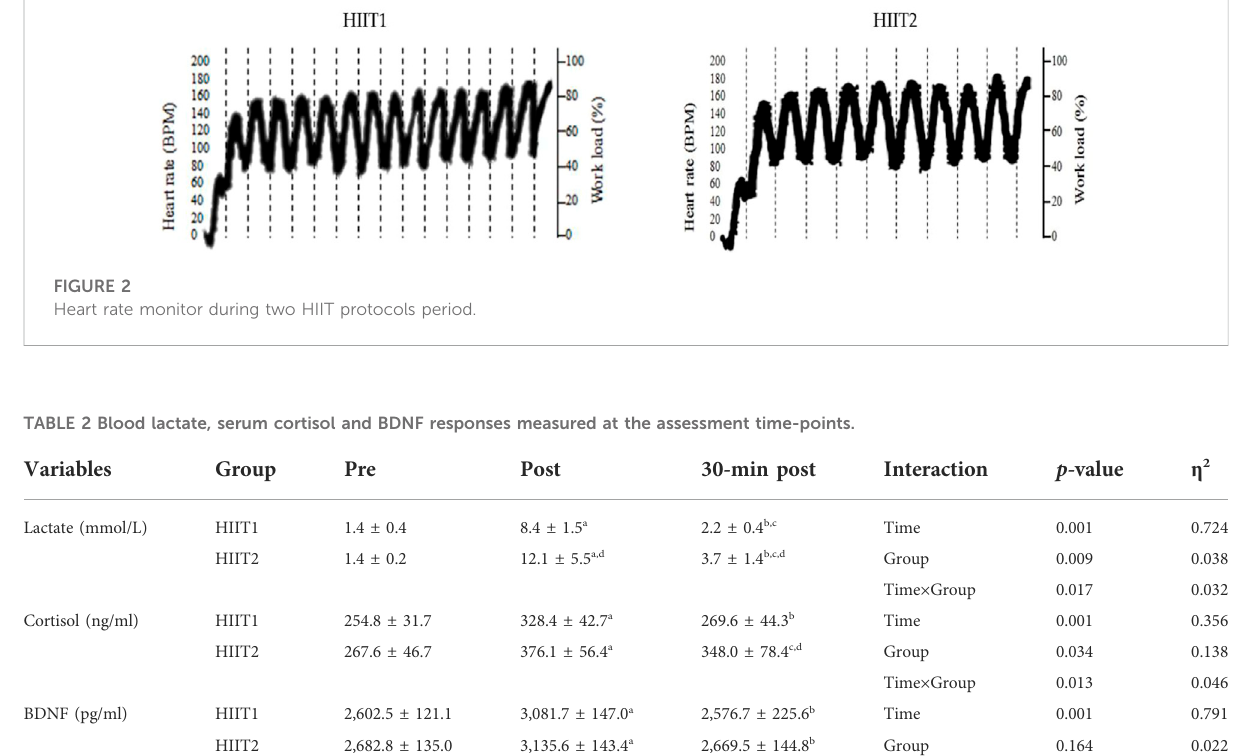
Figure 2A; HIIT2 group: r = 0.635, p < 0.05, Figure 2B).